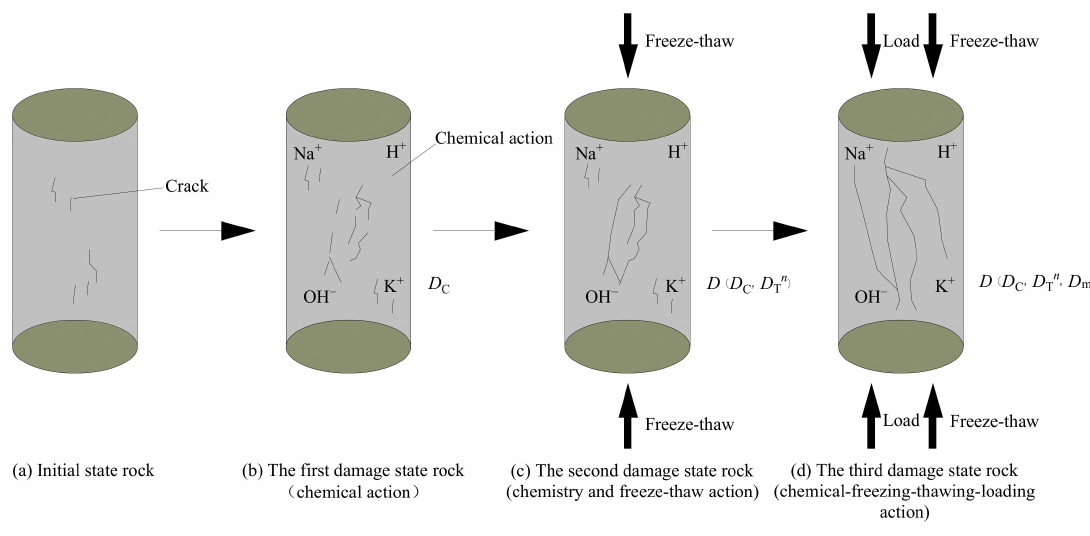
Figure 1. Schematic diagram of rock damage